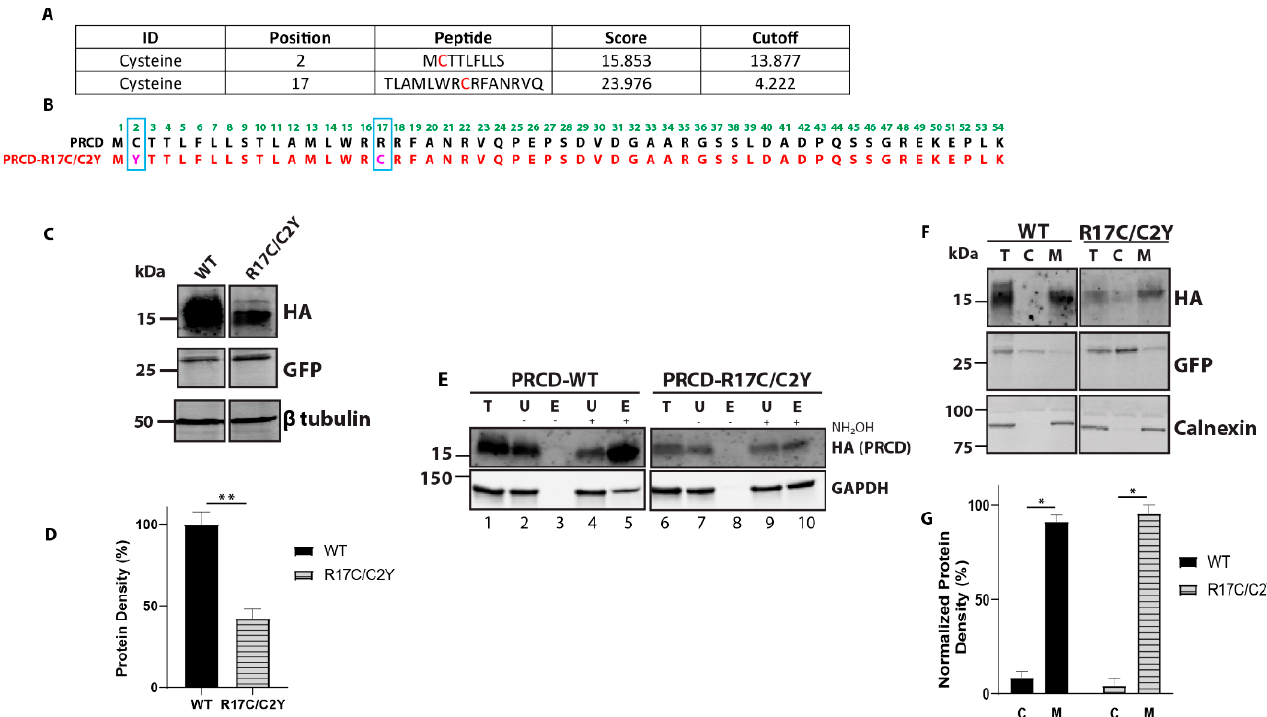
Figure 3. Cysteine residue of mutant PRCD-R17C/C2Y is palmitoylated and strongly binds with membranes despite the severe protein instability. ( A ) CSS-Palm prediction data showing PRCD-R17C is predicted to be lipidated in both Cys2 and Cys17 positions accessed on 30 November 2021 (http://csspalm.biocuckoo.org). ( B ) Cloning of PRCD double mutant, PRCD-R17C/C2Y, marked in pink with blue boxed along with PRCD-WT. ( C ) immunoblot showing the stability of proteins: PRCD-WT and PRCD-R17C/C2Y. GFP was used as an internal loading control, with β -tubulin as an external loading control. ( D ) quantification of protein stability from panel C ( n = 3, **, p < 0.005). ( E ) Acyl-RAC of PRCD-WT and PRCD-R17C/C2Y show mutant cysteine in the 17th position is palmitoylated. GAPDH serves as a positive palmitoylation control. ( F ) subcellular fractionation demonstrates both wildtype and mutant PRCD are primarily membrane (M) bound and absent from cytosol (C). As controls, GFP was used as a cytosolic marker and calnexin as a membrane marker. ( G ) quantification of protein localization to either cytosolic fraction or membrane fraction of PRCD-WT and PRCD-R17C/C2Y ( n = 3, *, p < 0.05).